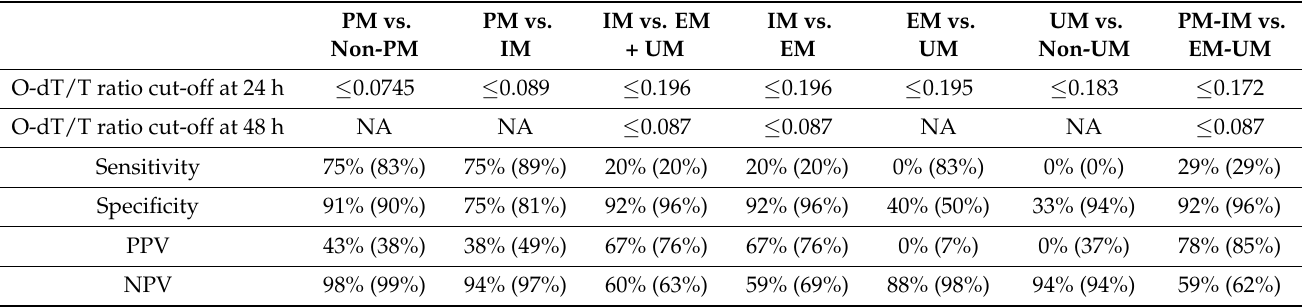
Table 4. Cut-off values of O-dT/T ratio at 24 h and 48 h and predictive performance of the bivariate classification tree model for phenotype